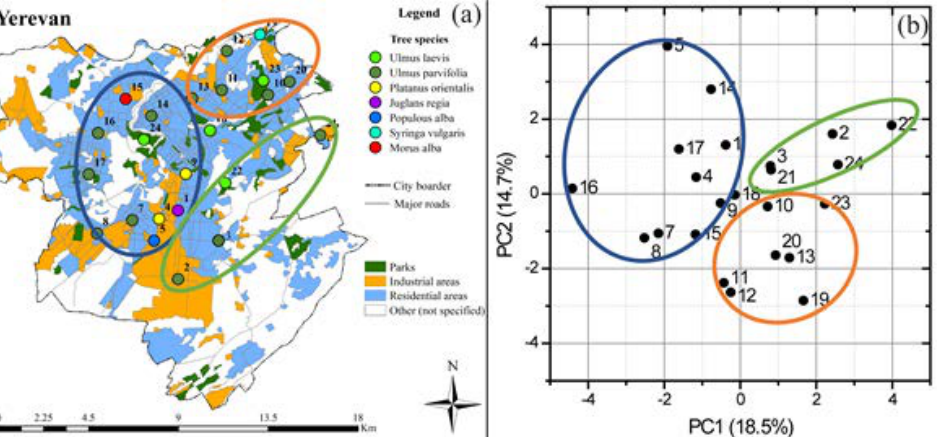
Figure 5. Yerevan territory tree leaves and soil element contents PCA results-spatial representation ( a ) and factor scores per case ( b